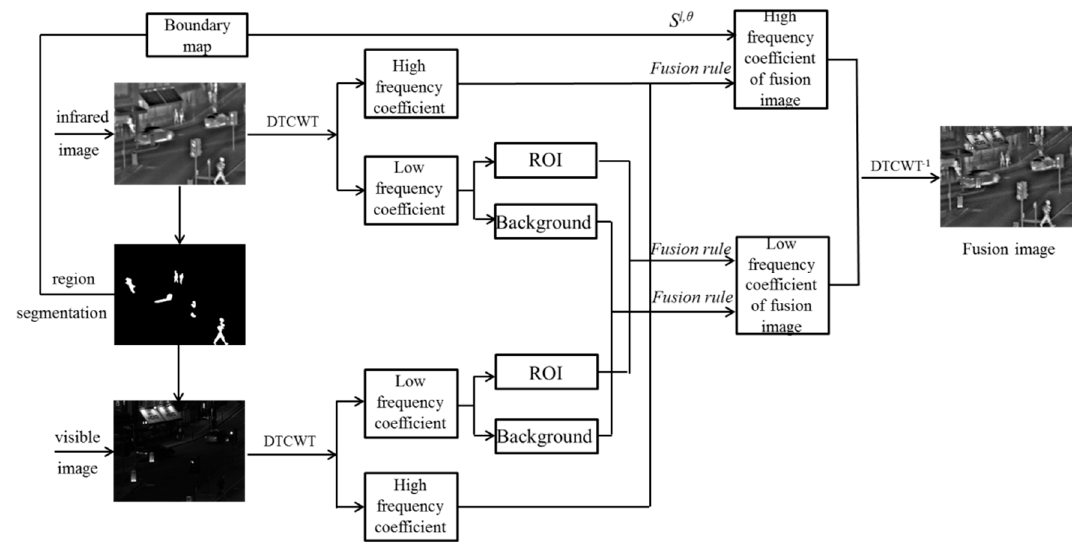
Figure 4. Fusion algorithm flowchart.